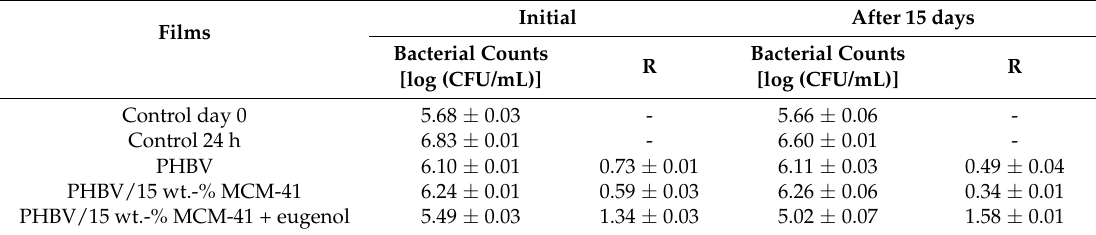
Table 9. Antibacterial activity against Escherichia coli ( E. coli ) in the closed system for the electrospun films of poly(3-hydroxybutyrate- co -3-hydroxyvalerate) (PHBV) and PHBV/Mobil Composition of Matter (MCM)-41 with